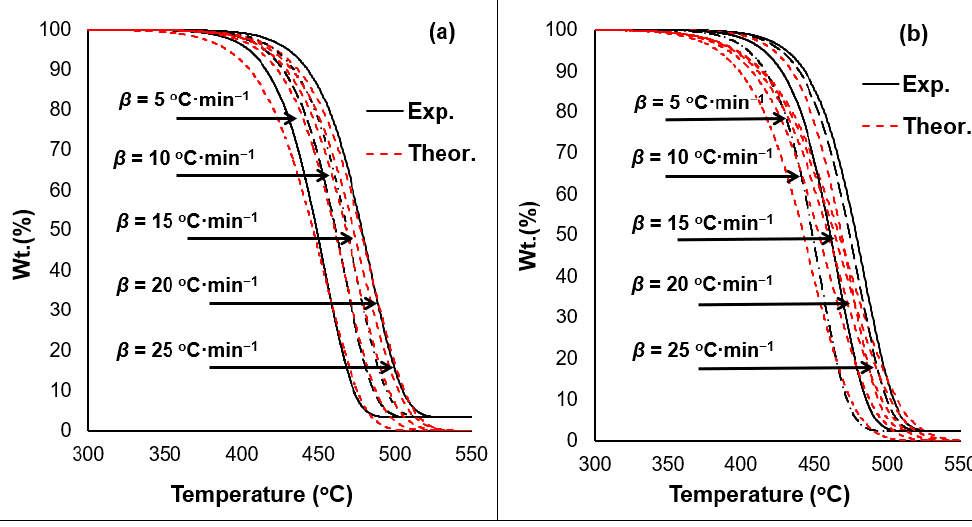
Figure 10. Experimental vs. theoretical results obtained from the analytical solution model for the ( a ) pre-exposed and ( b ) exposed 0/100 samples. Table 2. Apparent activation energy ( E a ), pre-exponential factor (A o ), and reaction order ( n ) results determined using the developed analytical solution mathematical model